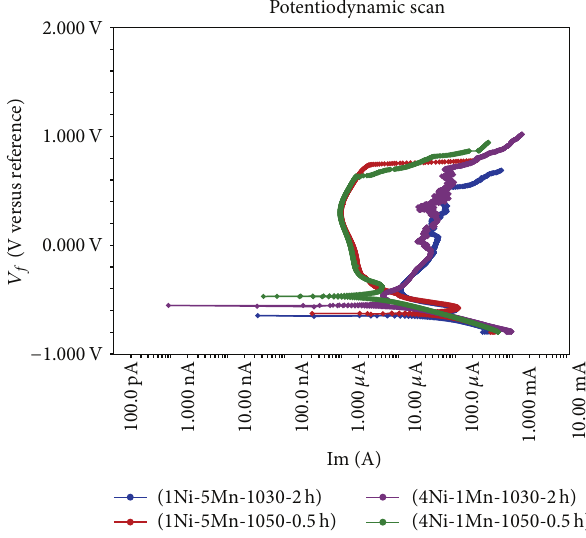
Figure 3: Potentiodynamic polarization response of the alloys in deaerated 0.1 MNaCl + 0.1 M H 2 SO 4 solution at 25 ∘ C and at a scan rate of 0.5